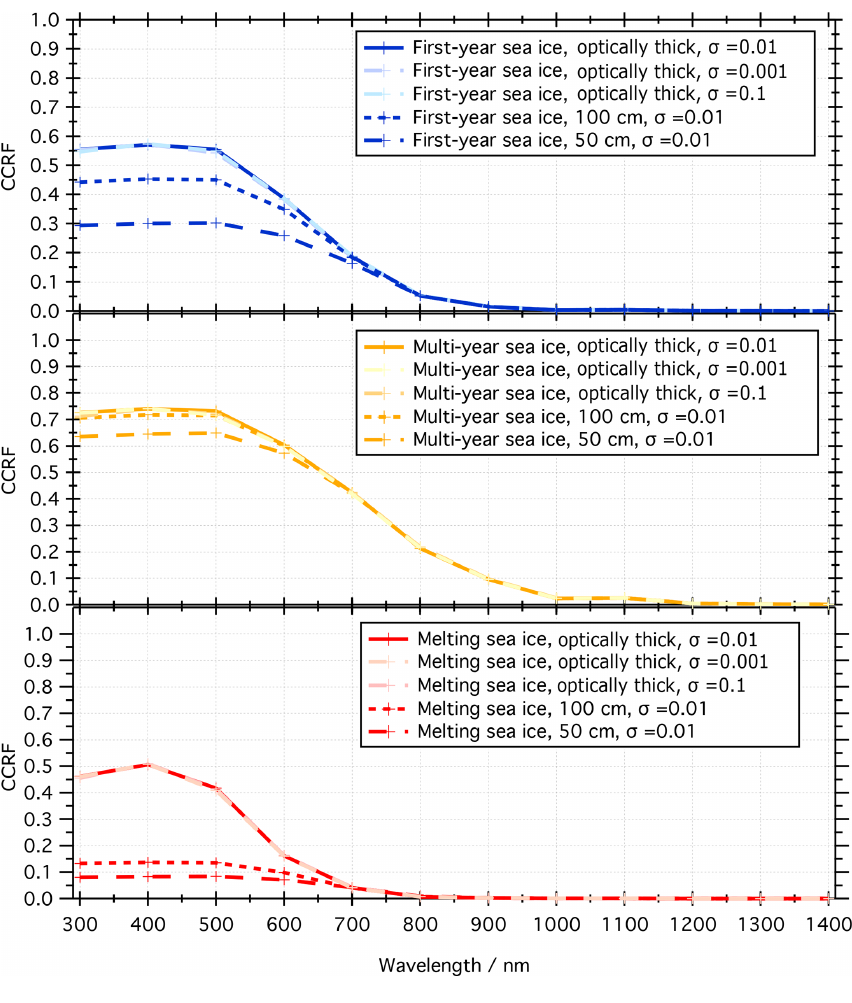
Figure 4. Nadir CCRF for first-year, multi-year and melting sea ice, from 300 to 1400 in 100nm steps with a solar zenith angle of θ = 60 ◦ and a roughness parameter of σ = 0 . 01. The CCRF of the different types of sea ice is plotted for an optically thick layer (185, 375 and 2000cm), 100 and 50cm. For each optically thick layer of sea ice, the nadir CCRF is plotted for surface roughnesses of σ = 0 . 001 and of σ = 0 . 1. The different sea ice parameters defined in this study are reported in Table 1. The changes in nadir CCRF owing to changes in roughness are hard to discern, especially relative to changes in thickness.